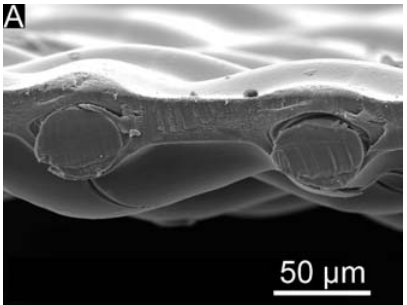
Figure 8. A cross section SEM micrograph of the commercially available HTI membrane. Picture from